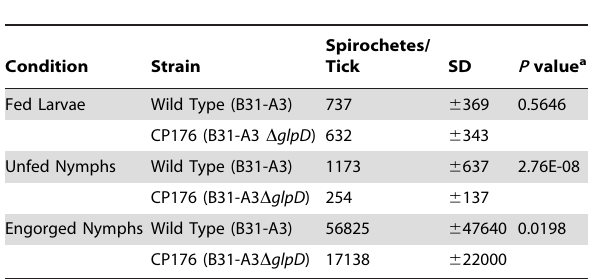
Table 2. Spirochete density at different tick